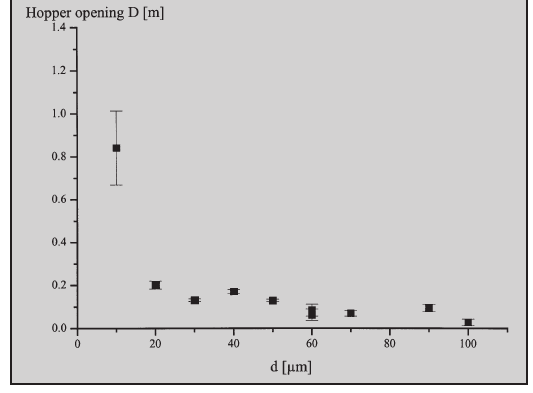
Figure 7 (left): Hopper opening for a trouble-free outflow dependent on the particle size. Figure 8: New designed powder viscometer.